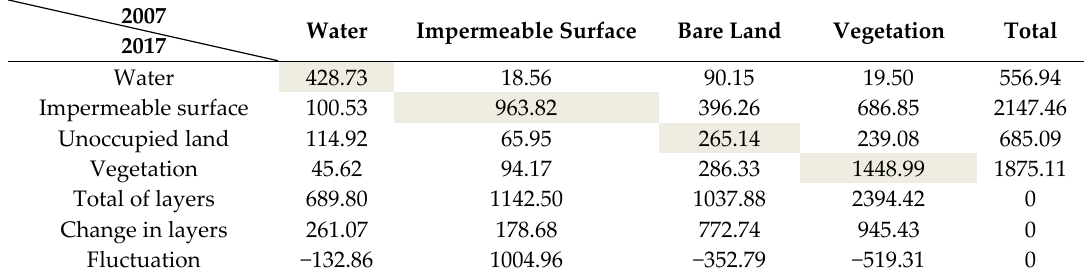
Table 2. Fluctuation of real coverage in inner-city areas and urbanization from 2007–2017 (unit: